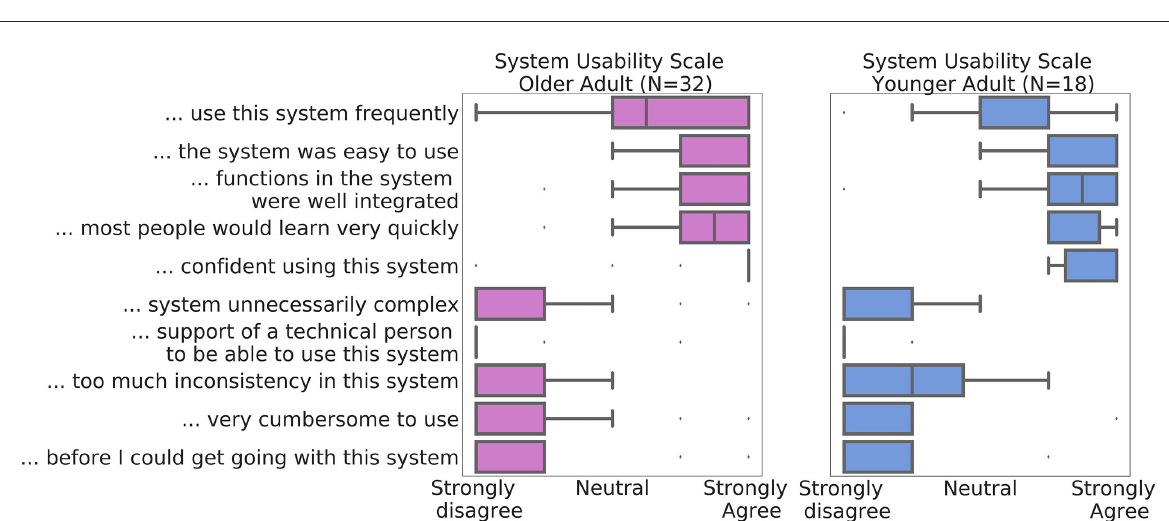
18). Whiskers denote interquartile range. Datapoints outside of the 1.5 * interquartile ranges were defined as =